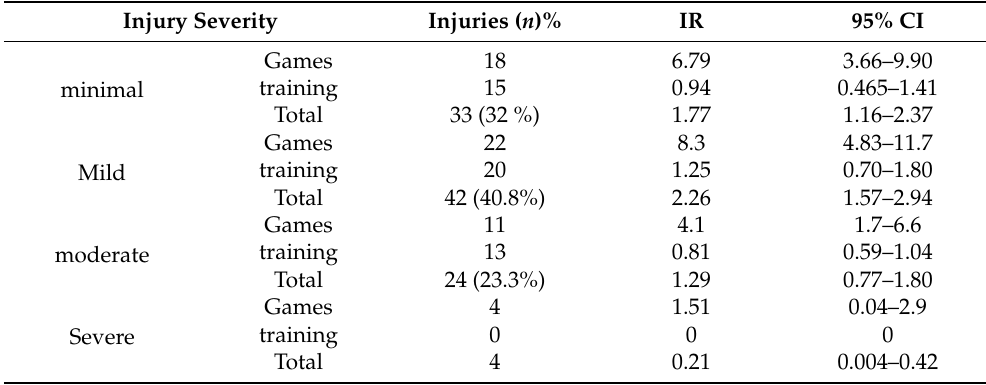
Table 3. Percentage of injuries, injury rate (number of injuries per 1000 h of exposure) and 95% confidence intervals (CI) during games and training according to injury severity.